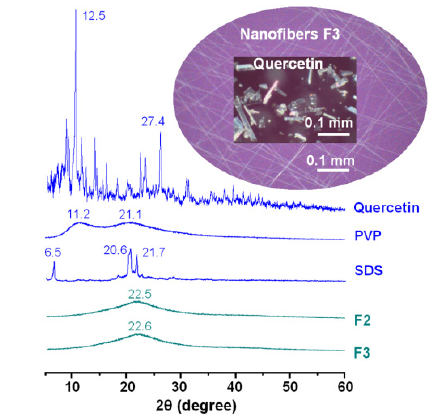
Figure 4. Physical status characterization: X-ray diffraction (XRD) patterns of the raw materials (quercetin, PVP and SDS) and the core-sheath nanofibres: F2 and F3 prepared by coaxial